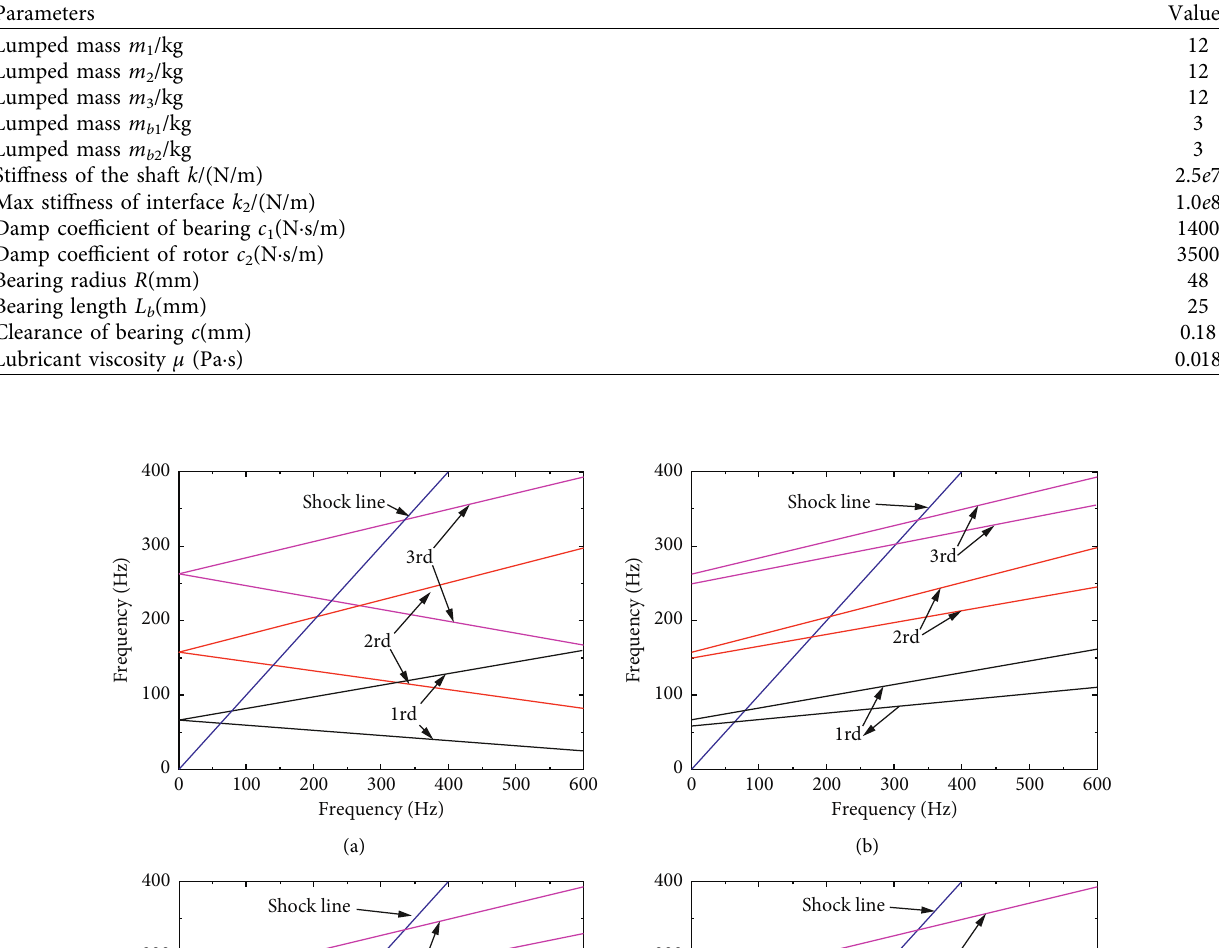
� k � 5 k � 10 k ′ , (b) k ′ , (c) k ′ , and (d) k 2 2 2 2 2 2